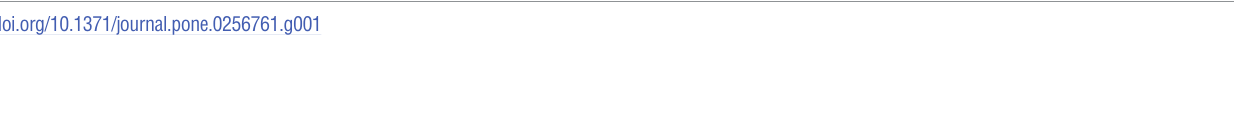
PLOS ONE | https://doi.org/10.1371/journal.pone.0256761 August 26,